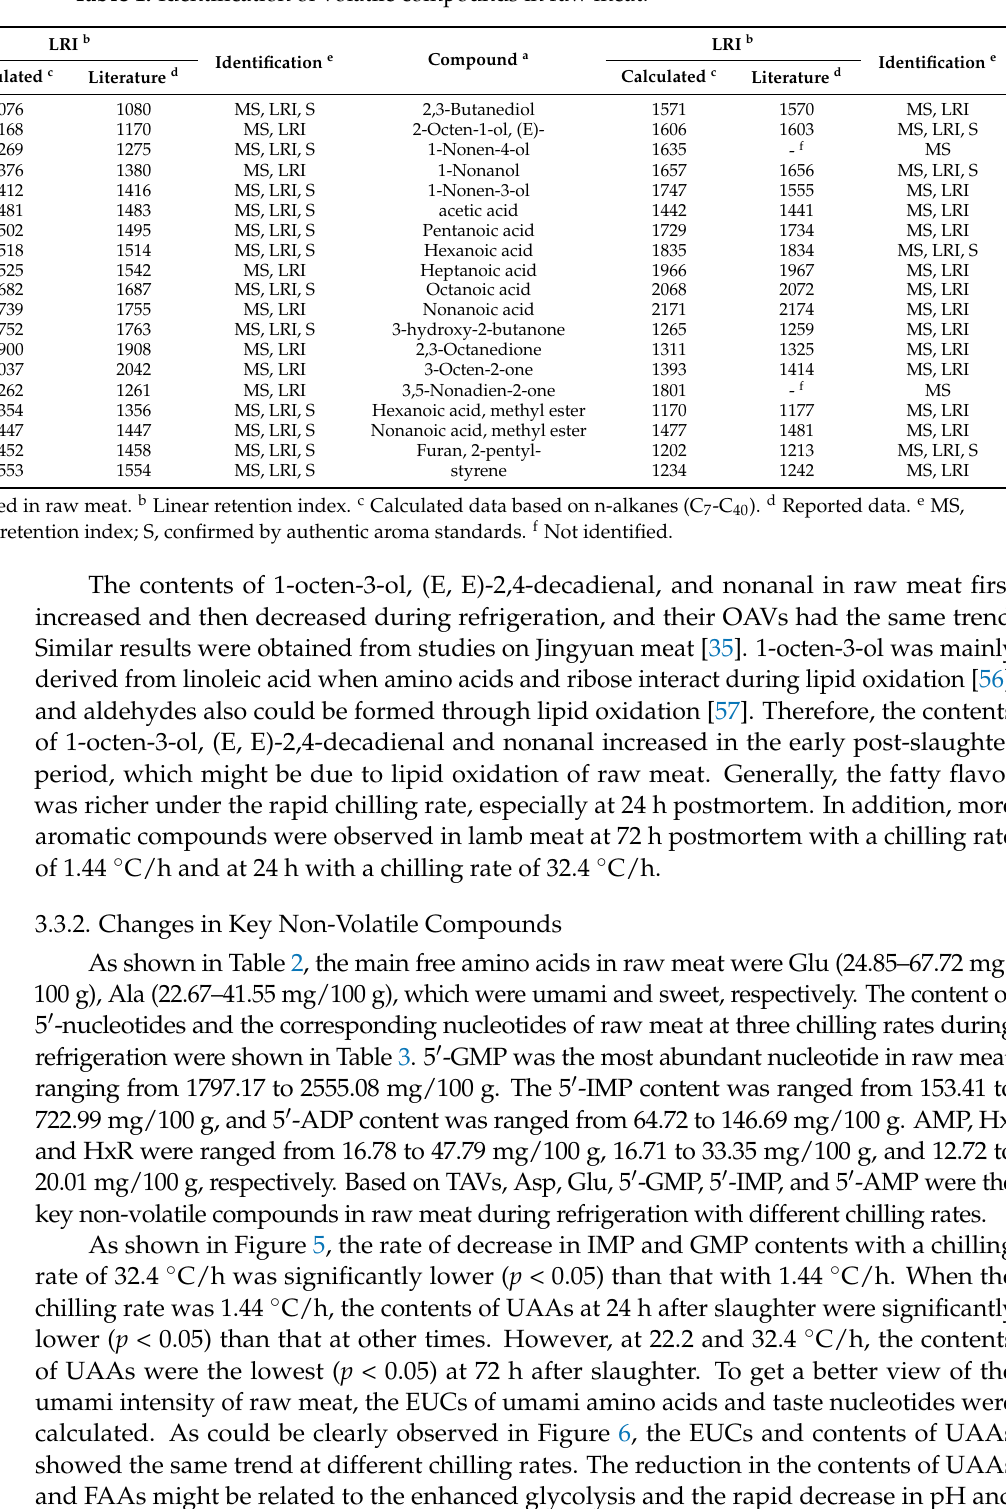
Table 1. Identification of volatile compounds in raw